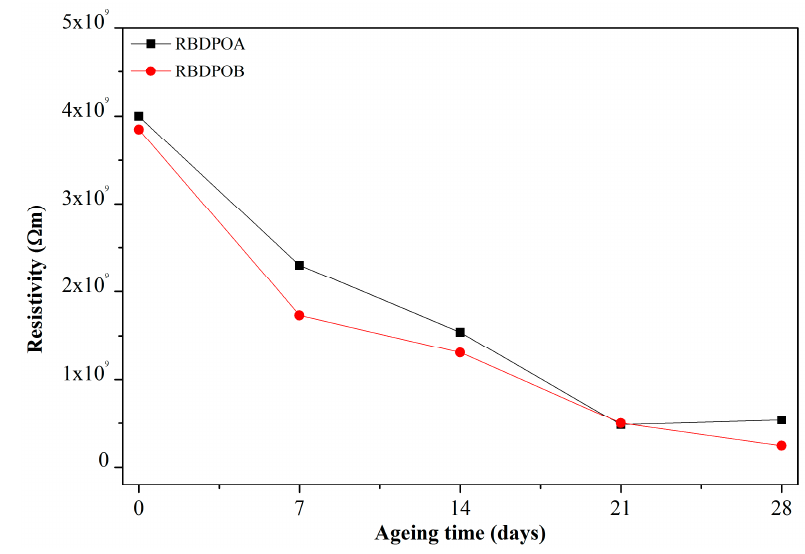
Figure 7. Resistivity of RBDPO aged at 170 ◦ C under open conditions.